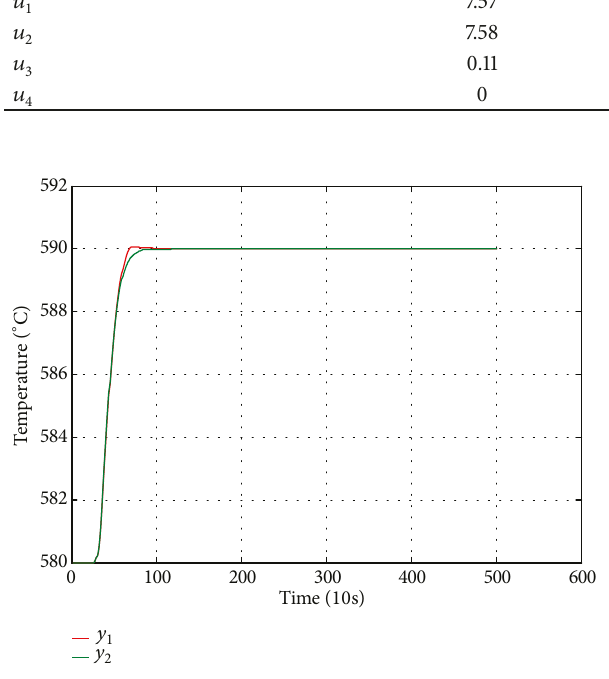
Figure11:Thevariationcurveofreheatsteamtemperaturewhenthe